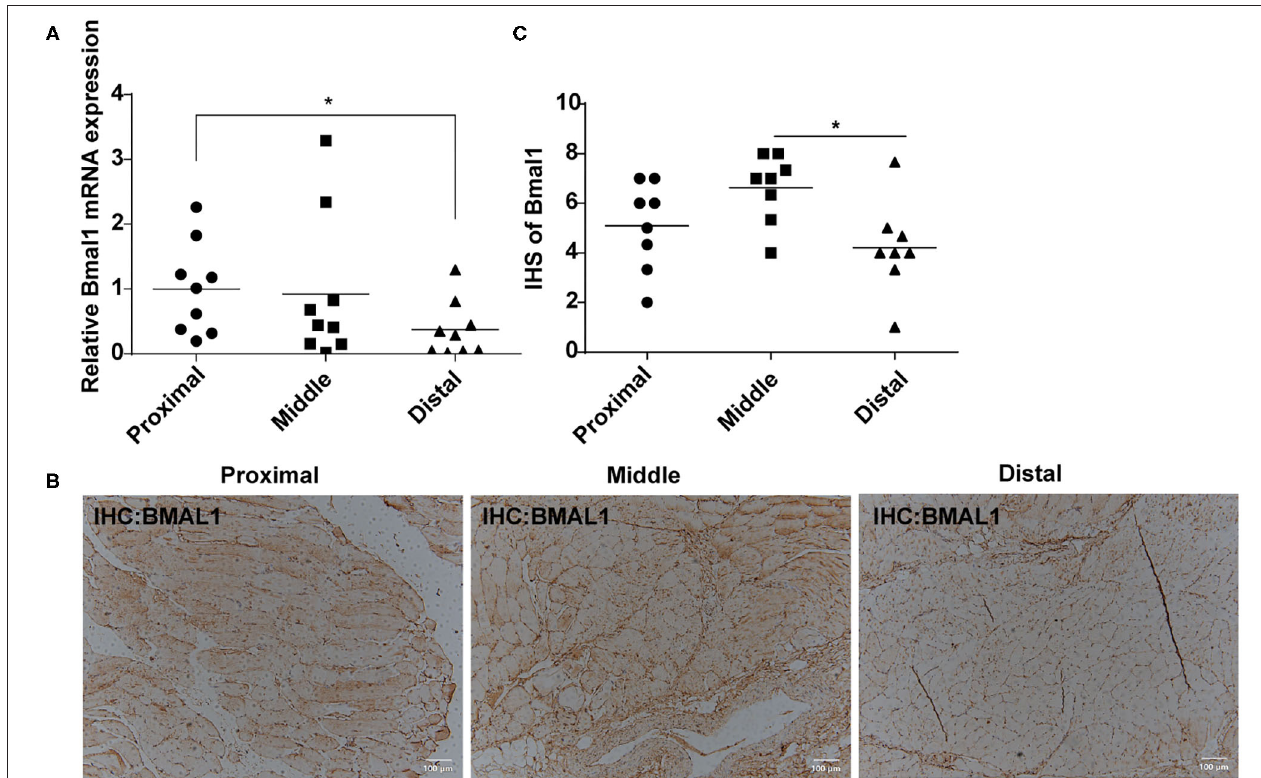
FIGURE 1 | Bmal1 expression is decreased in the distal lower limb muscle of critical limb ischemia (CLI) patients. (A) Relative mRNA expression of Bmal1 in the lower limb muscle of CLI patients detected by real-time PCR. Data are presented as mean ± SEM ( n = 9, one-way ANOVA with post-hoc Tukey test). * p < 0.05 distal lower limb vs. proximal lower limb. (B,C) Immunohistochemistry conducted in the lower limb muscle of CLI patients with specific anti-BMAL1 antibody with a dilution of 1:100. The immunohistochemical staining results were assigned with a mean score considering the intensity of staining and the proportion of cells with a positive reaction area. Each section was independently assessed by two pathologists without prior knowledge of patient data. Data are presented as mean ± SEM ( n = 8, one-way ANOVA with post-hoc Tukey test). * p < 0.05 distal lower limb vs. middle lower